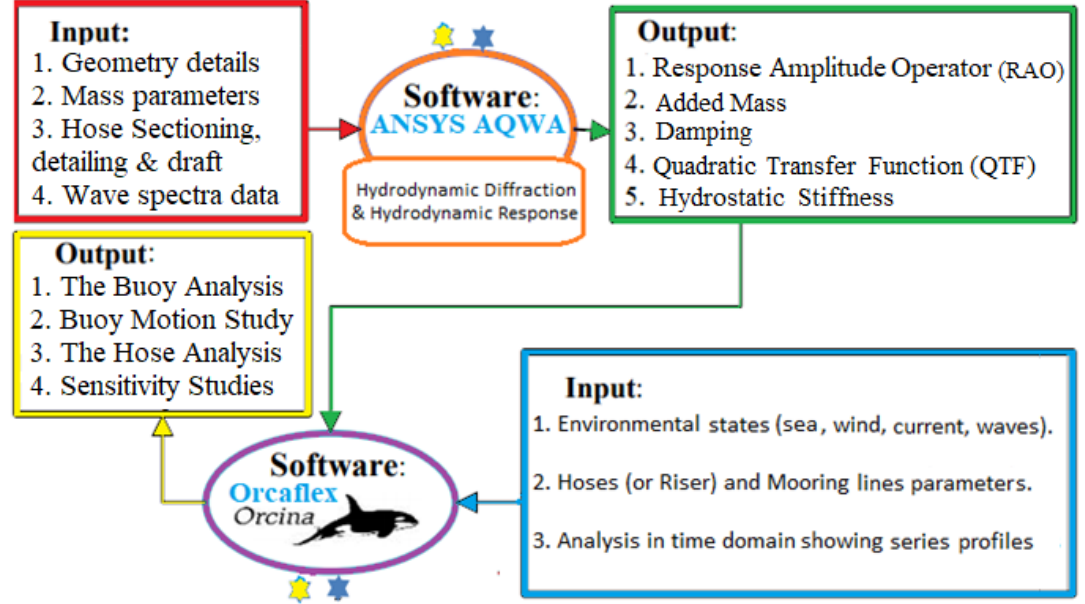
Figure 9. The methodology for the sensitivity studies in the numerical modeling.